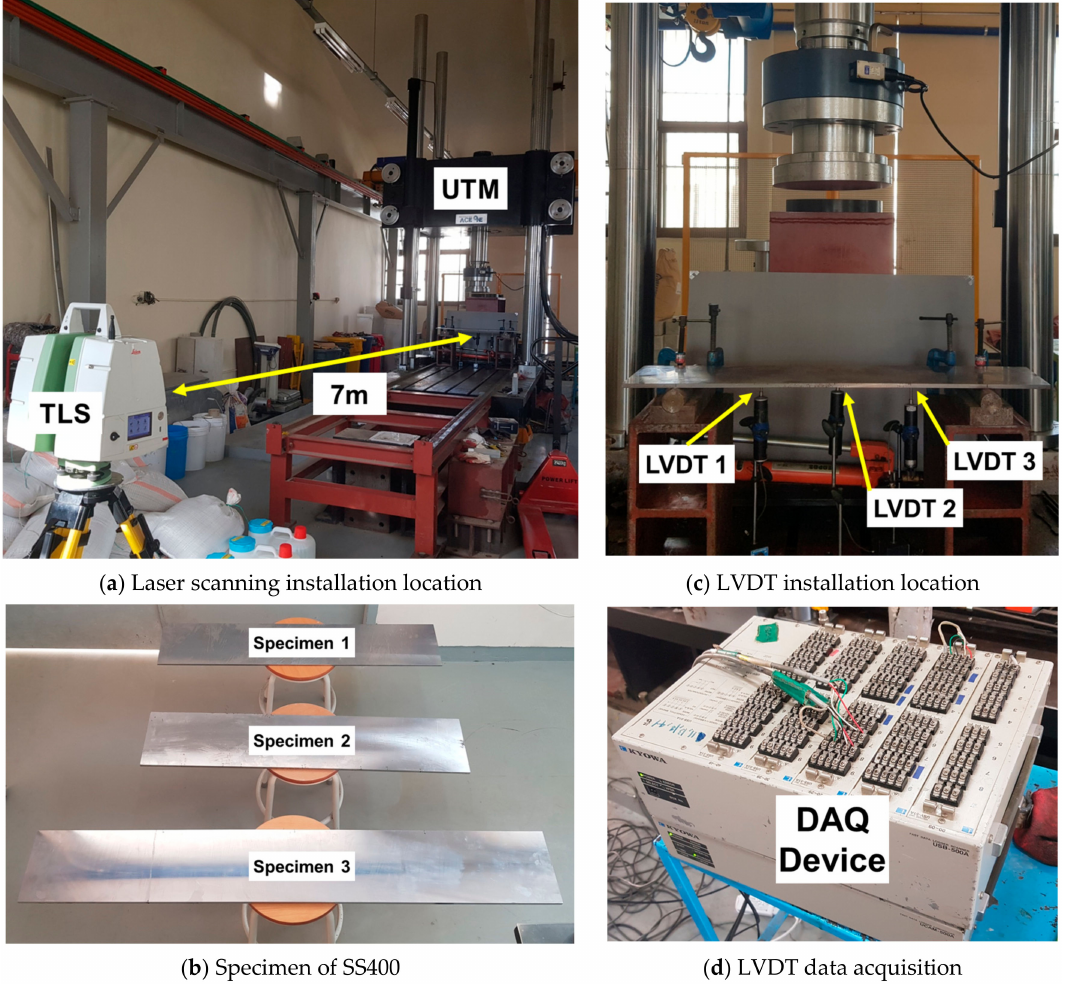
Figure 4. Laser scanning installation and experiment environment for static loading